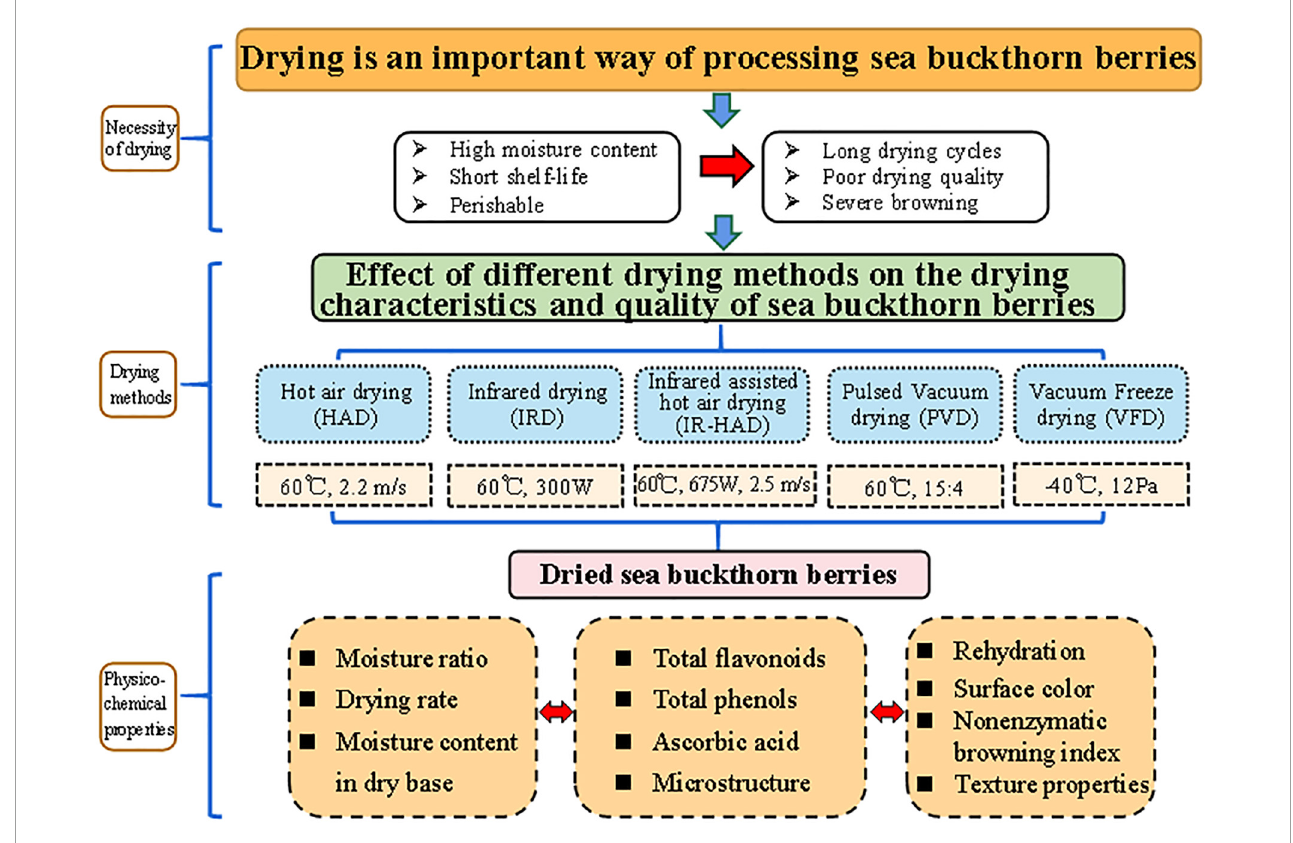
FIGURE1 Schematic overview of the experimental